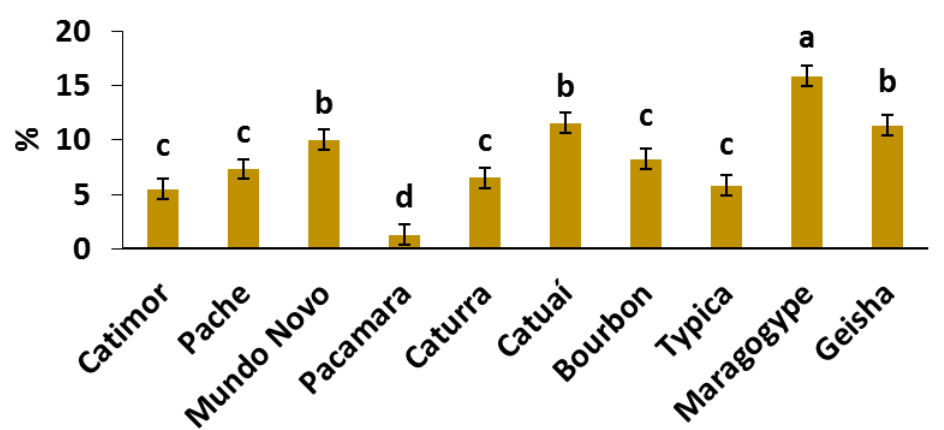
Figure 6. Coffee Leaf Rust severity in each cultivar in this experiment. The data shown are the result of averaging the lower, middle, and upper sections from April to June. Different letters indicate statistical differences according to the Scott-Knott test ( p ≤ 0.05).